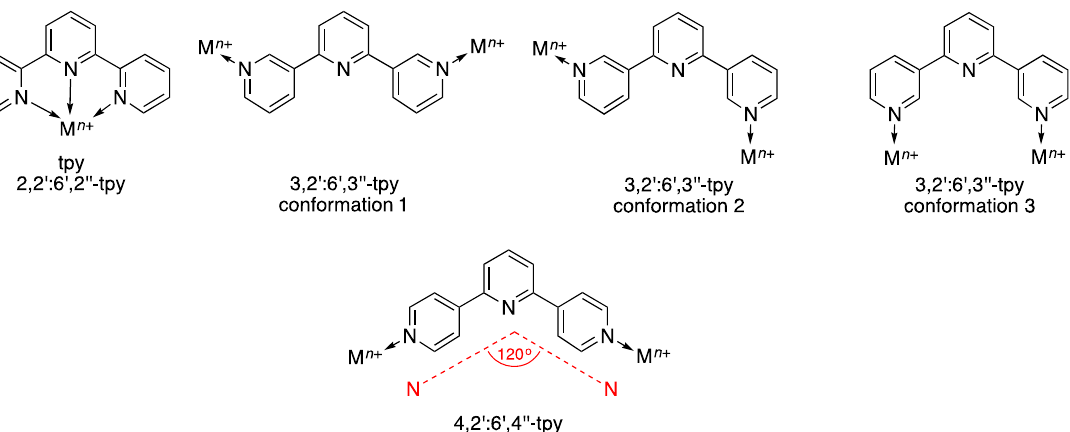
Scheme 2. Chelating metal-binding mode of tpy (monotopic ligand) versus ditopic metal-binding